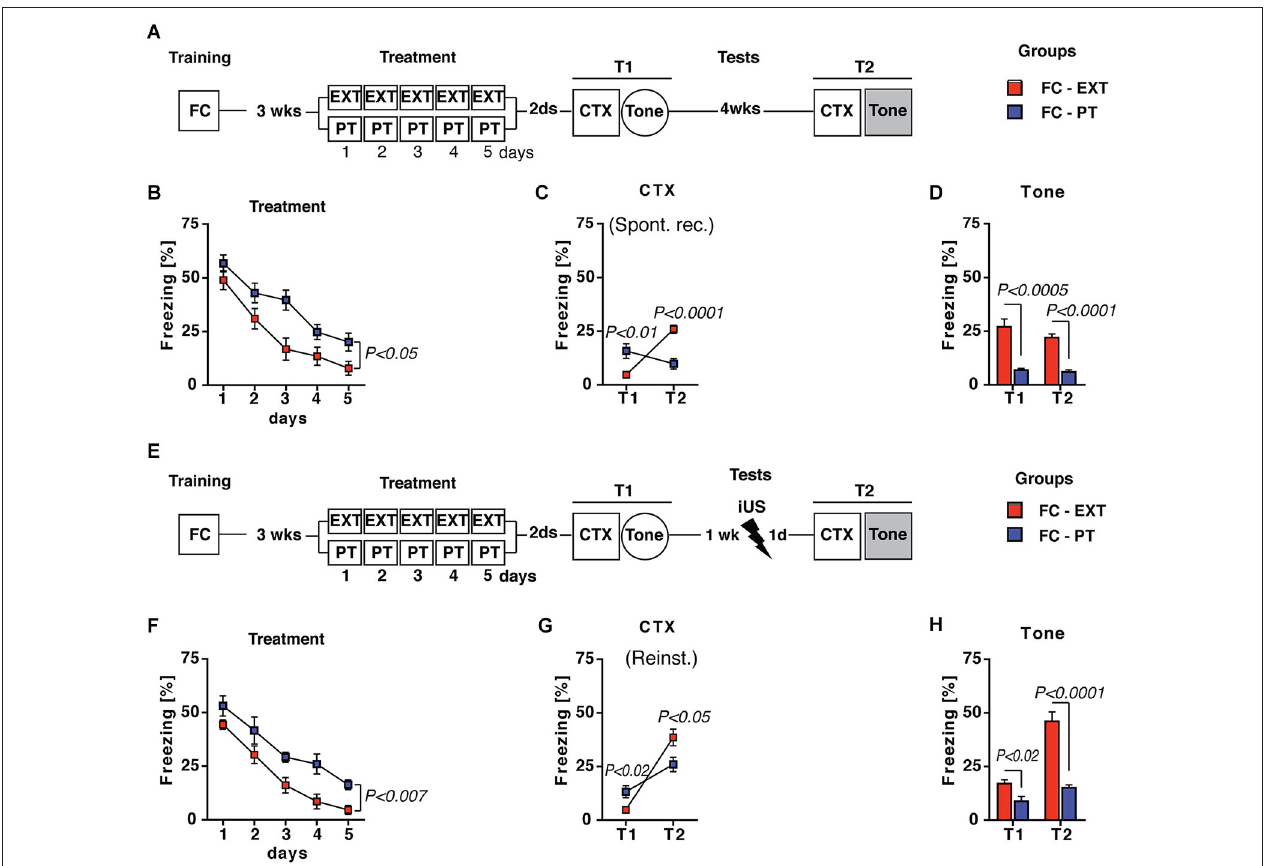
FIGURE 3 | PT treatment prevents spontaneous recovery and reinstatement . ( A ) Experimental schedule for spontaneous recovery evaluation. FC-EXT ( n = 8) and FC-PT ( n = 8) were submitted to contextual memory (CTX) and fear sensitization tests 2 days after treatment (T1). Spontaneous recovery was evaluated 4 weeks after T1 by exposing FC-EXT and FC-PT mice to the CTX (T2). Fear sensitization was again evaluated exposing animals to a new context with tone presentation (Tone, T2). ( B ) Five days of treatment reduced freezing (%) in both groups, although FC-EXT showed the lower levels of freezing ( C ). Freezing (%) in CTX carried out 2 days after treatment (T1) and 4 weeks later (T2). The results indicate that spontaneous recovery was prevented in FC-PT mice. ( D ) Freezing (%) in response to a neutral tone (Tone) in a new context at both T1 and